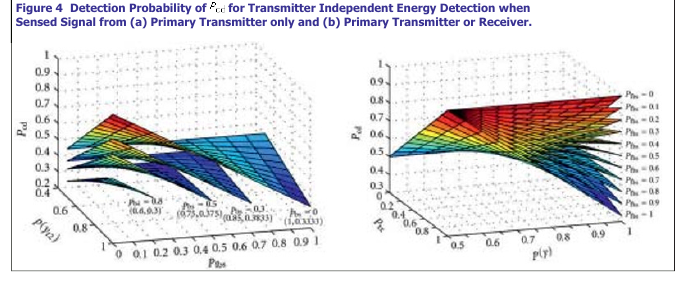
Figure 4 Detection Probability of for Transmitter Independent Energy Detection when Sensed Signal from (a) Primary Transmitter only and (b) Primary Transmitter or Receiver.